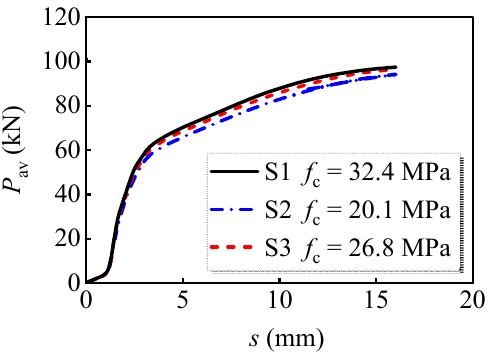
Figure 10. Average load versus slip curves for models with different concrete compressive